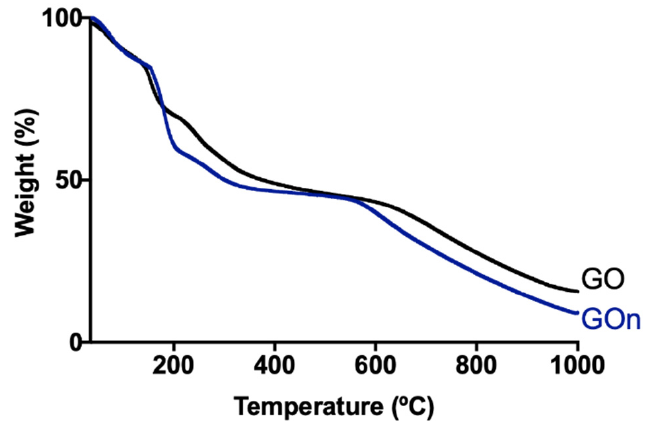
Figure 7. Thermal decomposition of GOn and GO. TGA curves and weight loss values for GOn (blue line) and GO (black line).